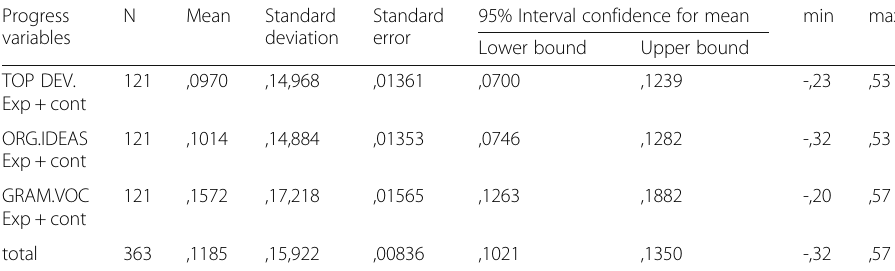
N Mean Standard